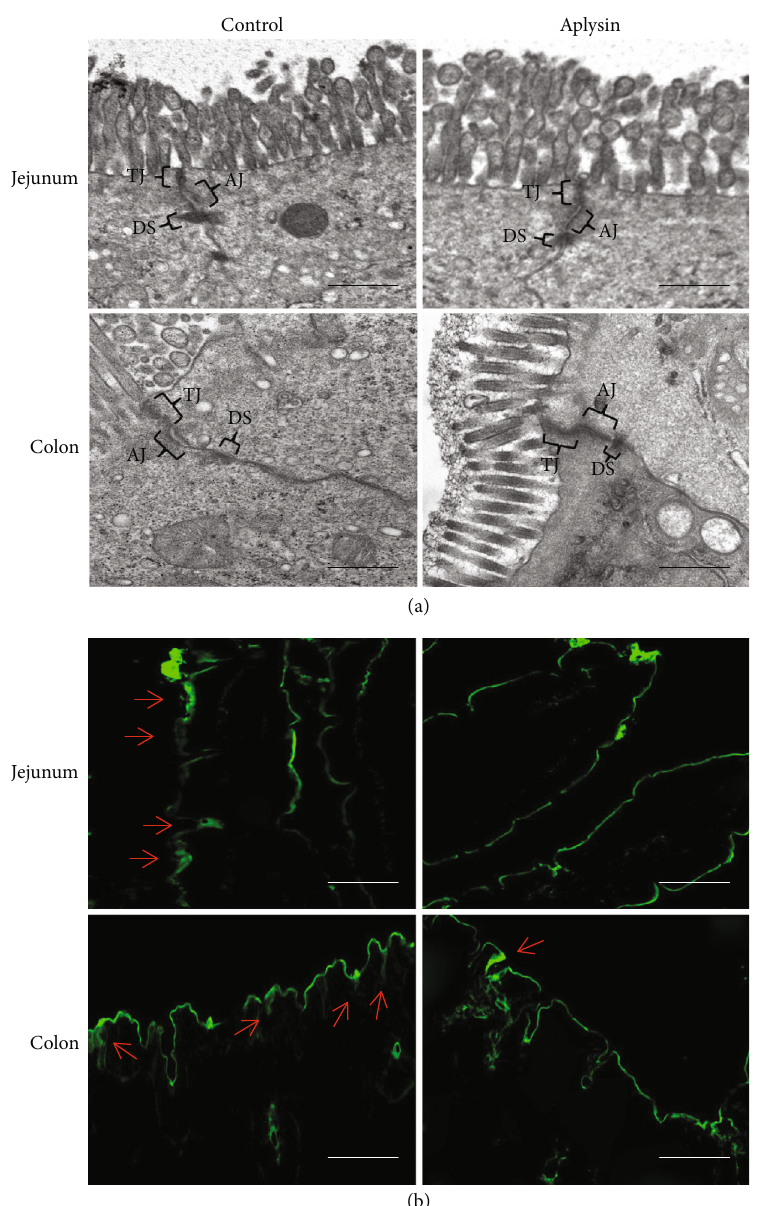
Figure 5: The permeability analysis of the jejunum and colon of mice. (a) The ultrastructure of the jejunum and colon examined by transmission electron microscopy. TJ: tight junction; AJ: adherens junction; DS: desmosomes. Scale bar = 400nm . (b) The permeability assessment of the jejunum and colon by tracer experiments. The green fl uorescence signals indicate biotin distribution; the red arrows indicate tracer leakage. Scale bar = 50 μ m